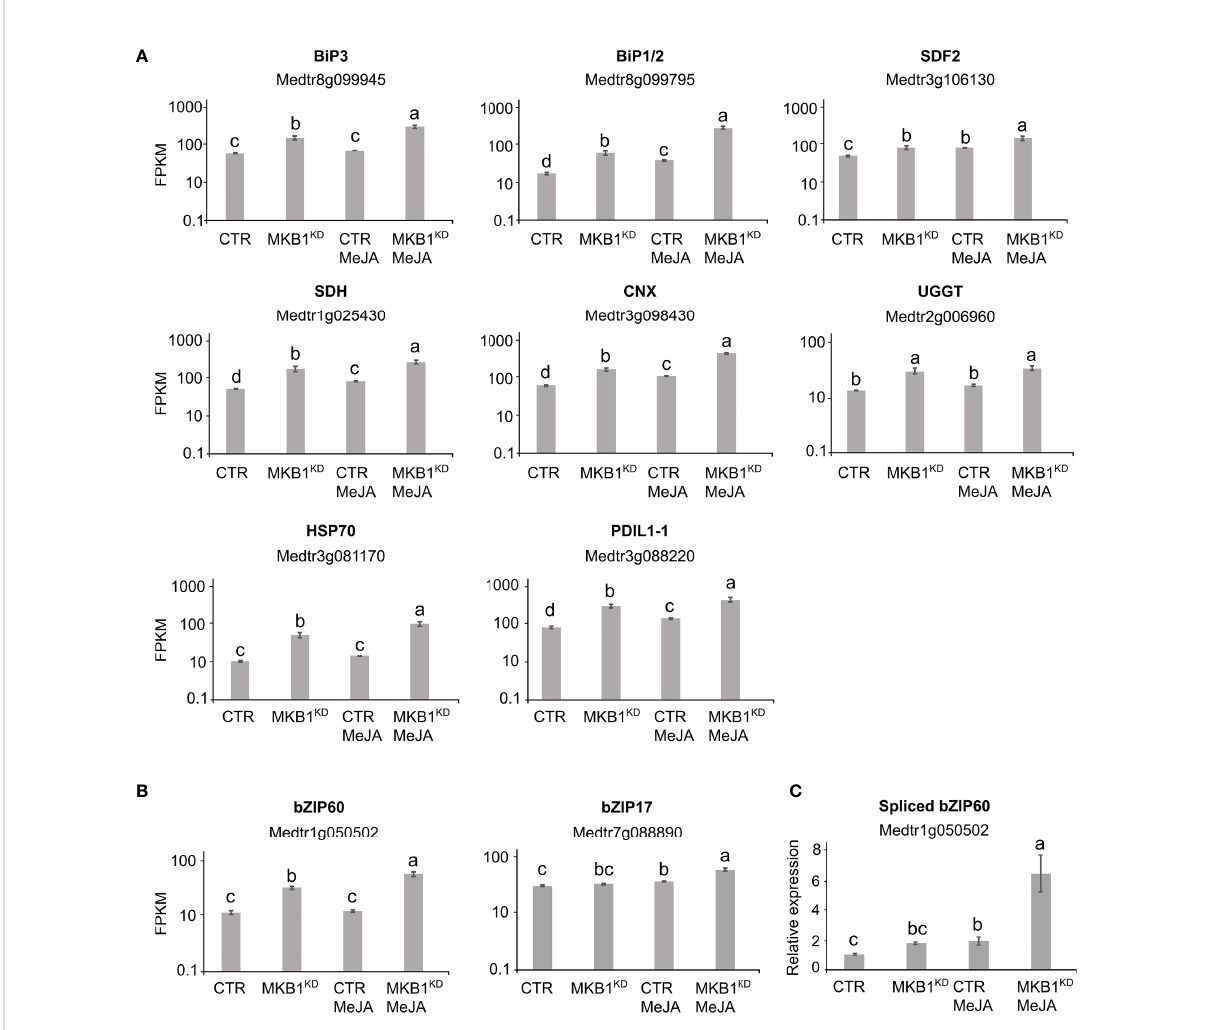
FIGURE 2 Silencing of MKB1 and MeJA elicitation both trigger an ER stress response in M. truncatula . (A, B) RNA-Seq analysis of M. truncatula orthologs of A. thaliana ER stress marker (A) and bZIP TF (B) genes in CTR and MKB1 KD roots, mock- or MeJA-treated for 4 h. The Y-axis represents the normalized fragments per kb of exon per million fragments mapped (FPKM) values. Error bars designate SE (n = 3, except for MeJA-elicited CTR where n = 2). (C) qRT-PCR analysis for the detection of spliced bZIP60 transcripts in CTR and MKB1 KD roots, mock- or MeJA-treated for 4 h. The error bars designate SE (n = 3). Different letters indicate statistically signi fi cant differences at P < 0.05 as determined by ANOVA, post hoc Tukey